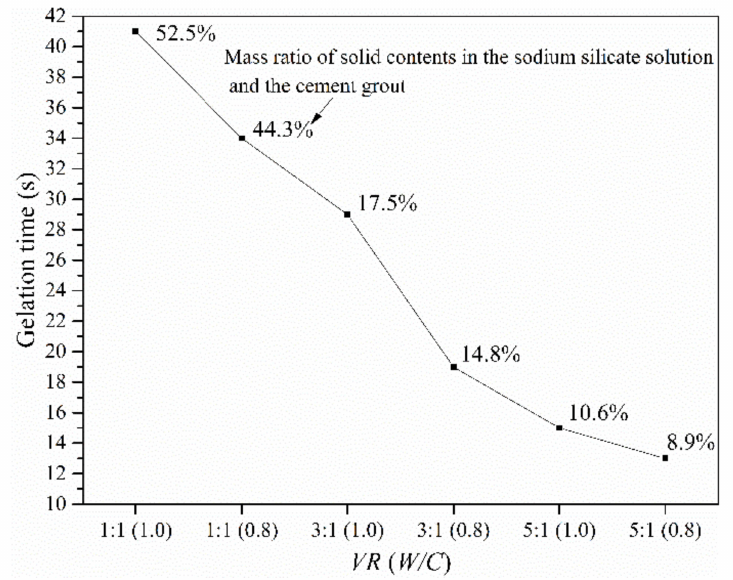
Figure 2. Gelation time of CSG with different mixing proportions in the air.